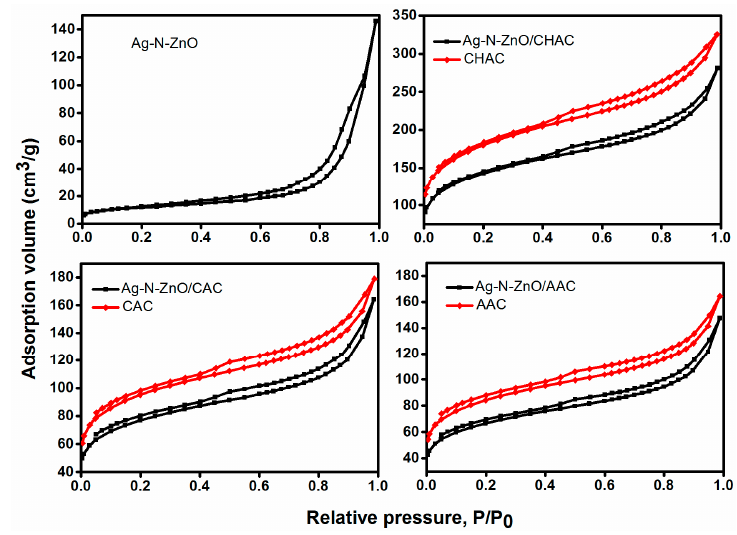
Figure 2. N 2 adsorption/desorption isotherms curves of Ag-N-ZnO, Ag-N-ZnO/CHAC, Ag-N-ZnO/CAC and Ag-N-ZnO/AAC.